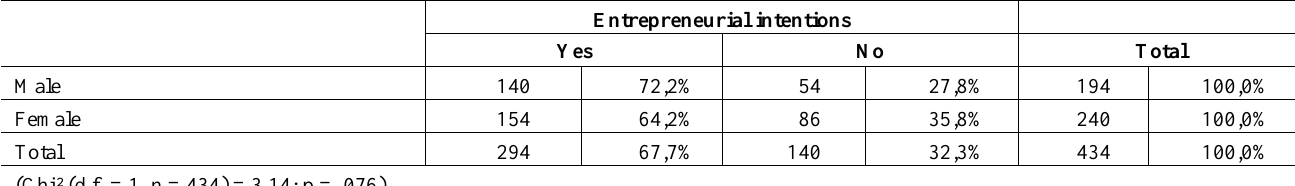
Entrepreneurial intentions